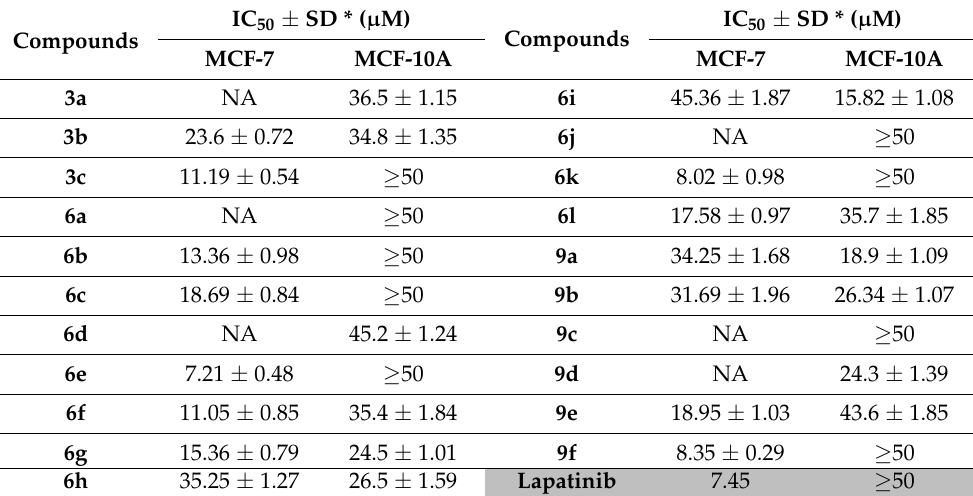
Table 1. Cytotoxic IC 50 values of the tested compounds against MCF-7 and MCF-10A lines using the MTT assay.